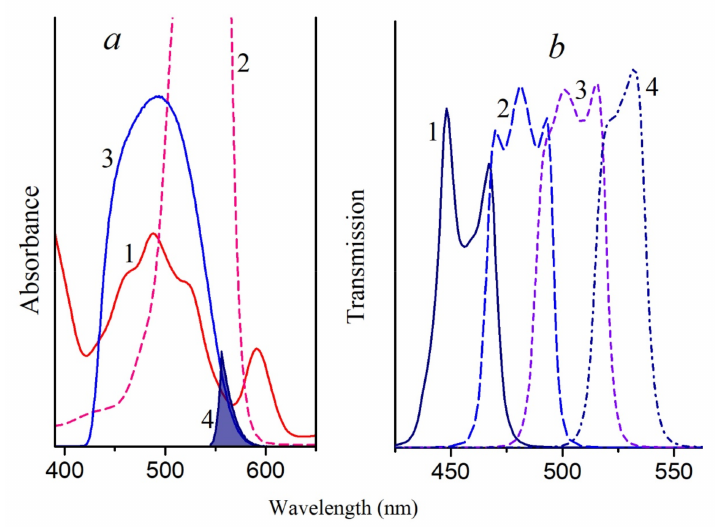
Figure 8. ( a )—Absorption spectra of Alc. vinosum membranes (1) and RB (2), as well as the trans- mission spectra of the combination of light filters SZS-22 + ZhS-12 (3) (blue light) and SZS-23 + OS-13 (4); ( b )—transmission spectra of bandpass light filters: 1—440–465; 2—465–490; 3—490–515; 4—515–540